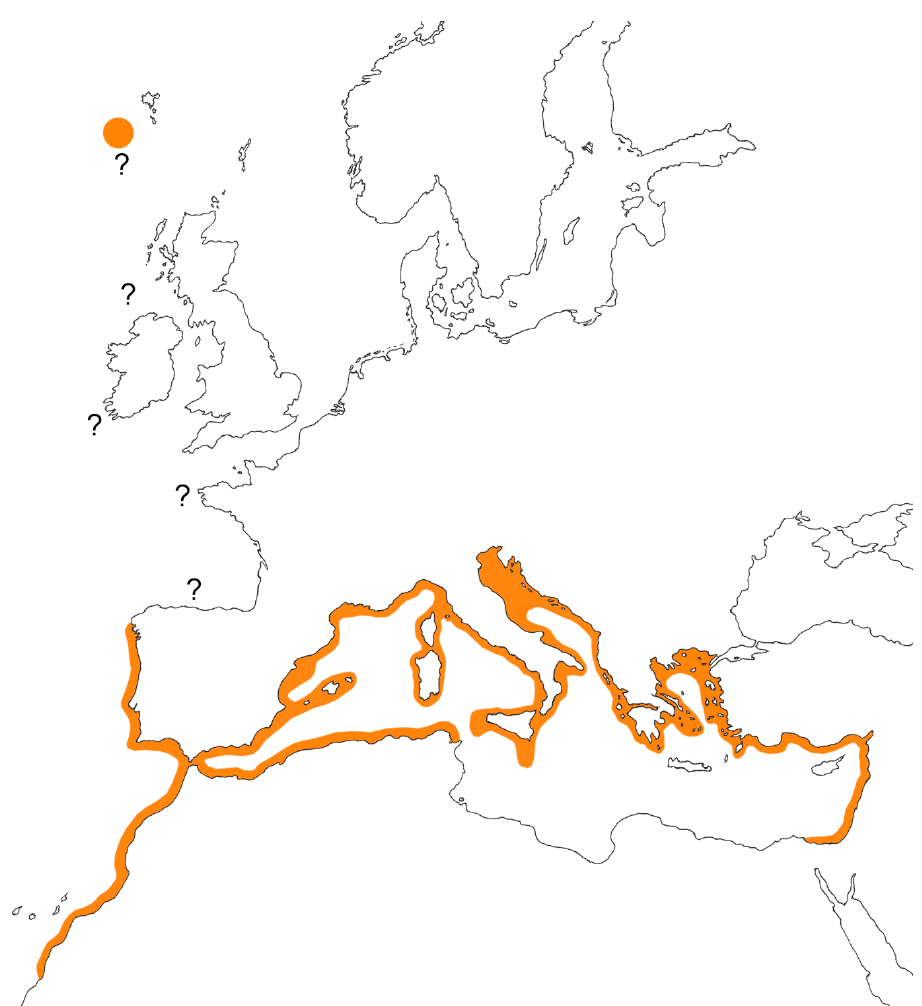
Figure 11. Present geographic distribution of Trisopterus capelanus . The occurrence southwest of the Faroe islands is only based on one specimen. The most likely route to there is west of Great Britain or even west of Ireland, indicated with question marks.